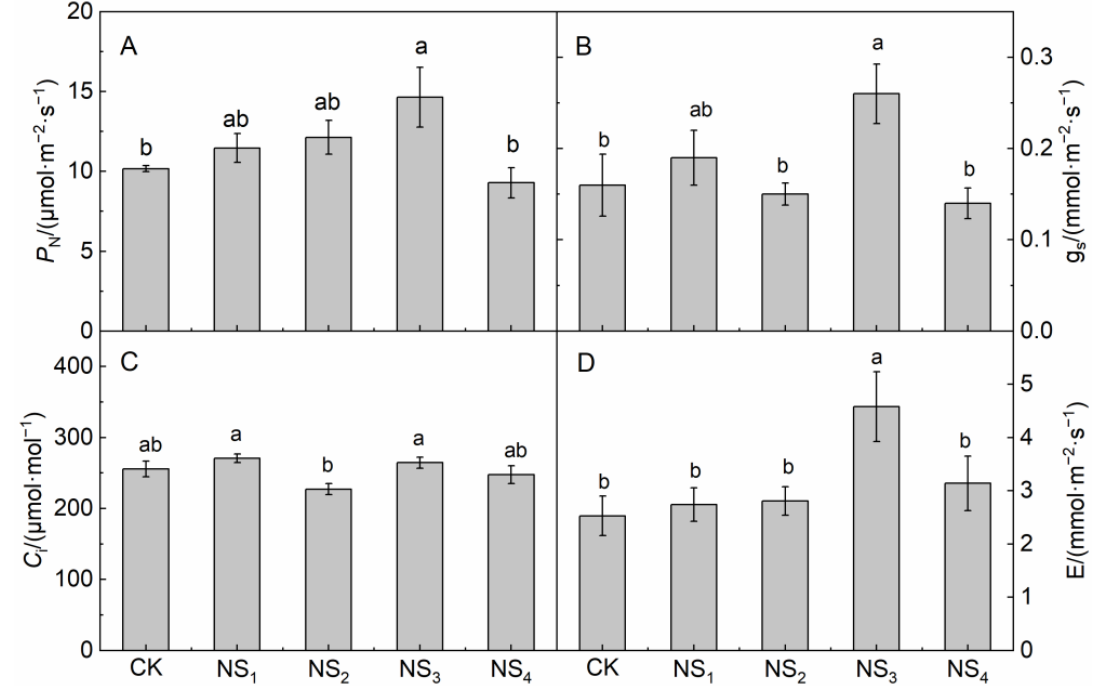
Figure 1. Effects of foliage spraying of NaHSO 3 on et photosynthetic rate ( P N ) ( A ), stomatal conductance ( g s ) ( B ), intercellular carbon dioxide concentration ( C i ) ( C ), and transpiration rate( E ) ( D ) of O. violaceus . Values are the means of five repetitions ± SE. Bars with different letters show significant differences at P < 0.05 (Duncan).